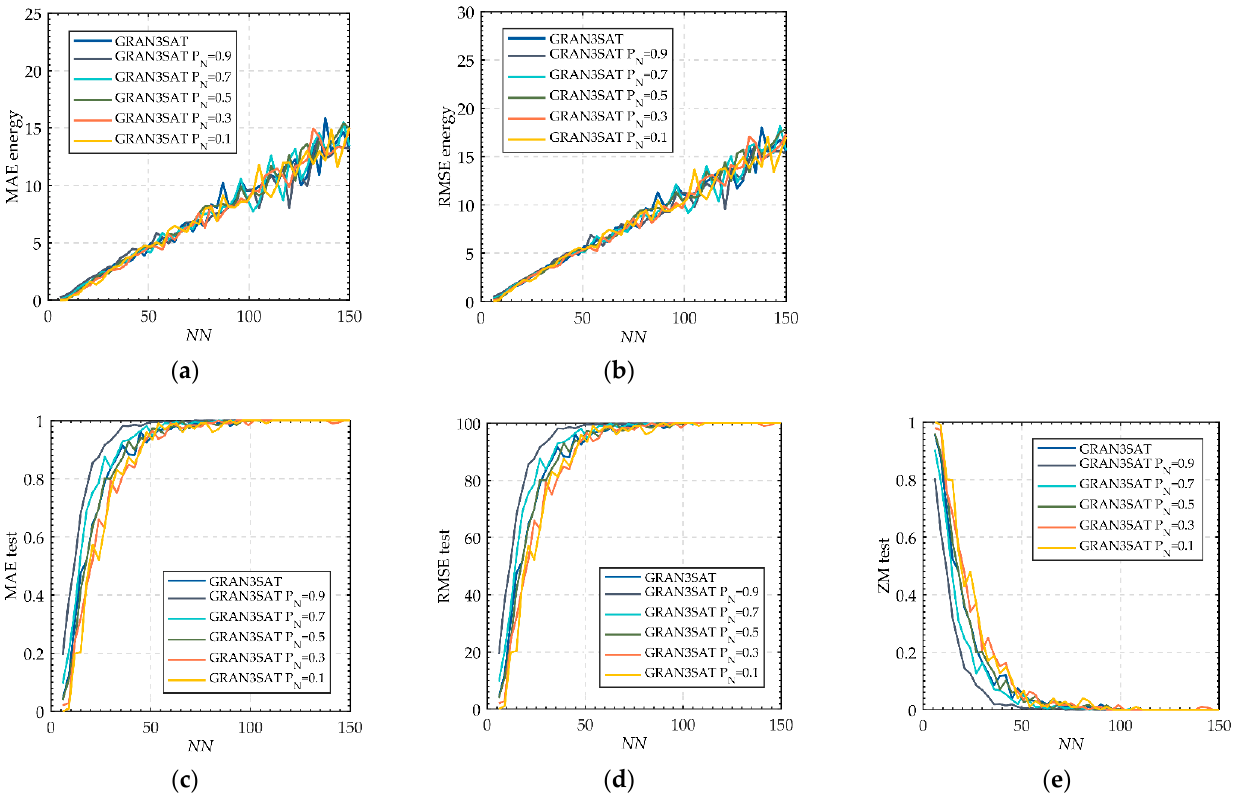
Figure 7. Error performance for ( a ) MAE energy , ( b ) RMSE energy , ( c ) MAE test , ( d ) RMSE test , and ( e ) ZM test . Table 12. The average NC when NN = 100.